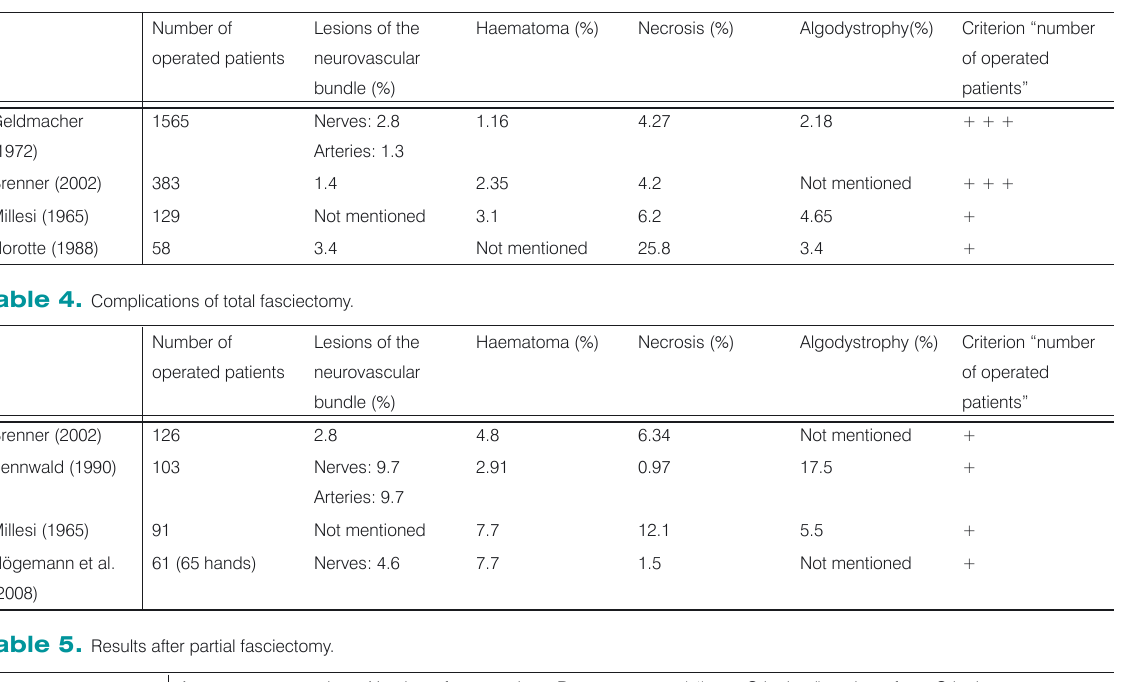
Table 3. Complications of partial fasciectomy.